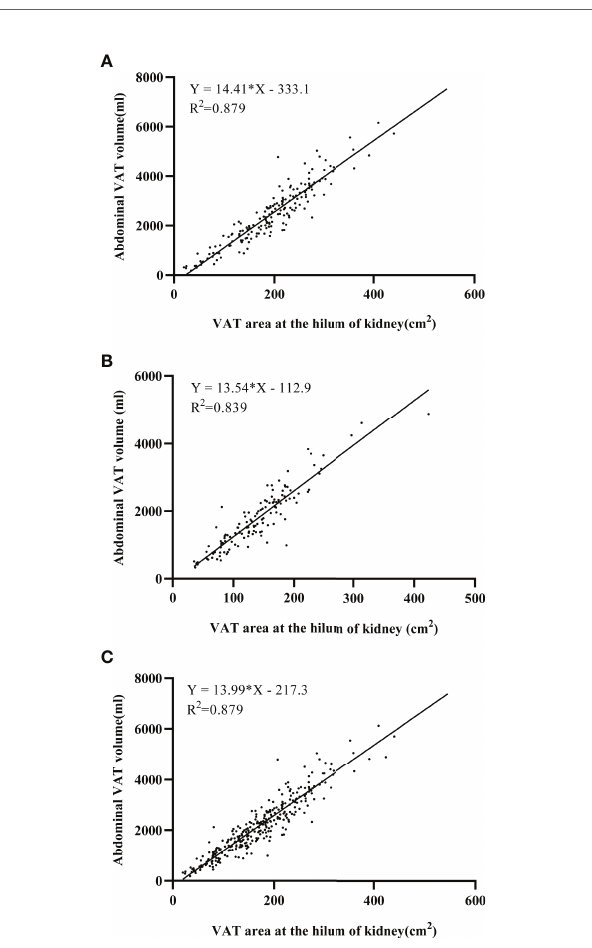
Correlation coef fi